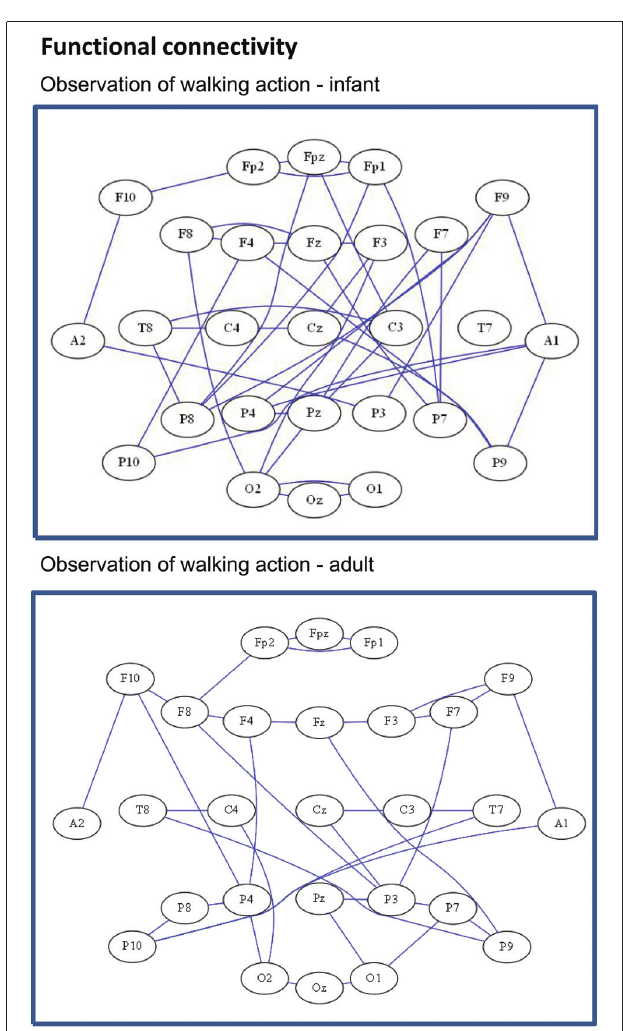
FIGURE 2 | Representative functional connectivity headplot graphs from both an infant subject (top), and an adult subject (bottom), for the walking condition demonstrating differences in the topological organization of the network